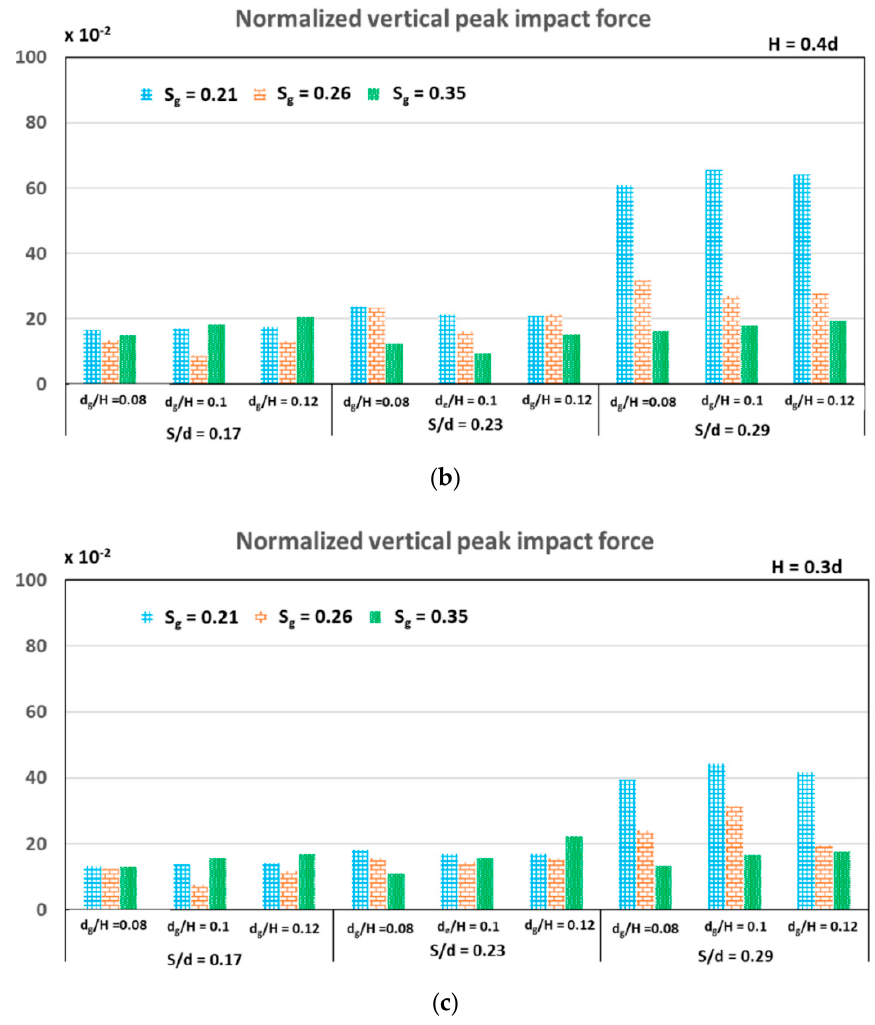
Figure 12. Peak vertical impact force vs. normalized airgap for different girder depths, d g = 0.08, 0.1 and 0.12 m for wave heights at different normalized airgaps S/d = 0.29, 0.23 and 0.17 ( a ) H = 0.5d, ( b ) H = 0.4d and ( c ) H = 0.3d.